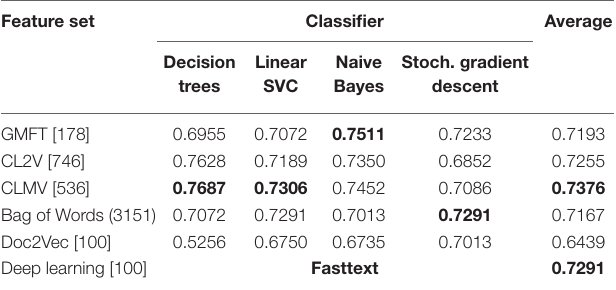
TABLE 5 | Comparison of feature sets and classifiers for sentiment classification of tweets. Feature set